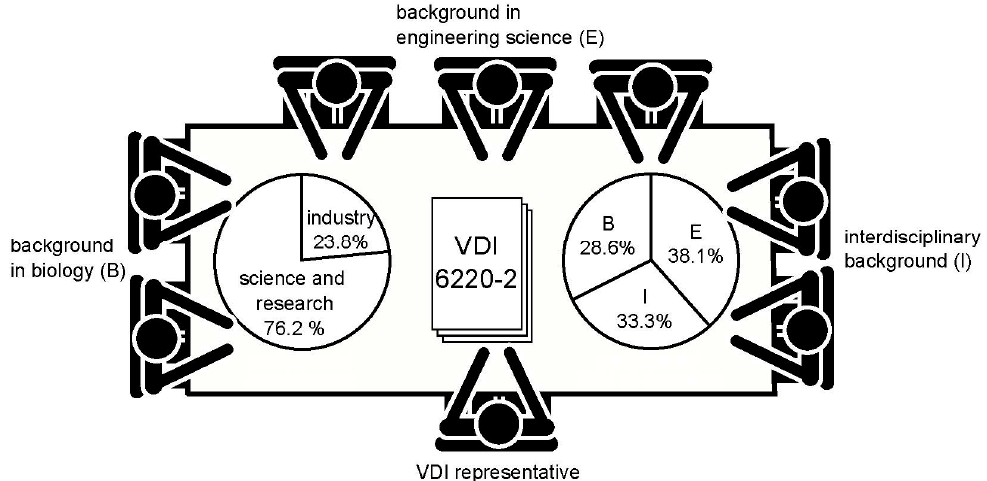
Figure 1. Participants in the expert panel. B: biology; E: engineering; I: interdisciplinary. In total, 21 members, one guest, and one secretary collaborated on developing a process description for biomimetics.